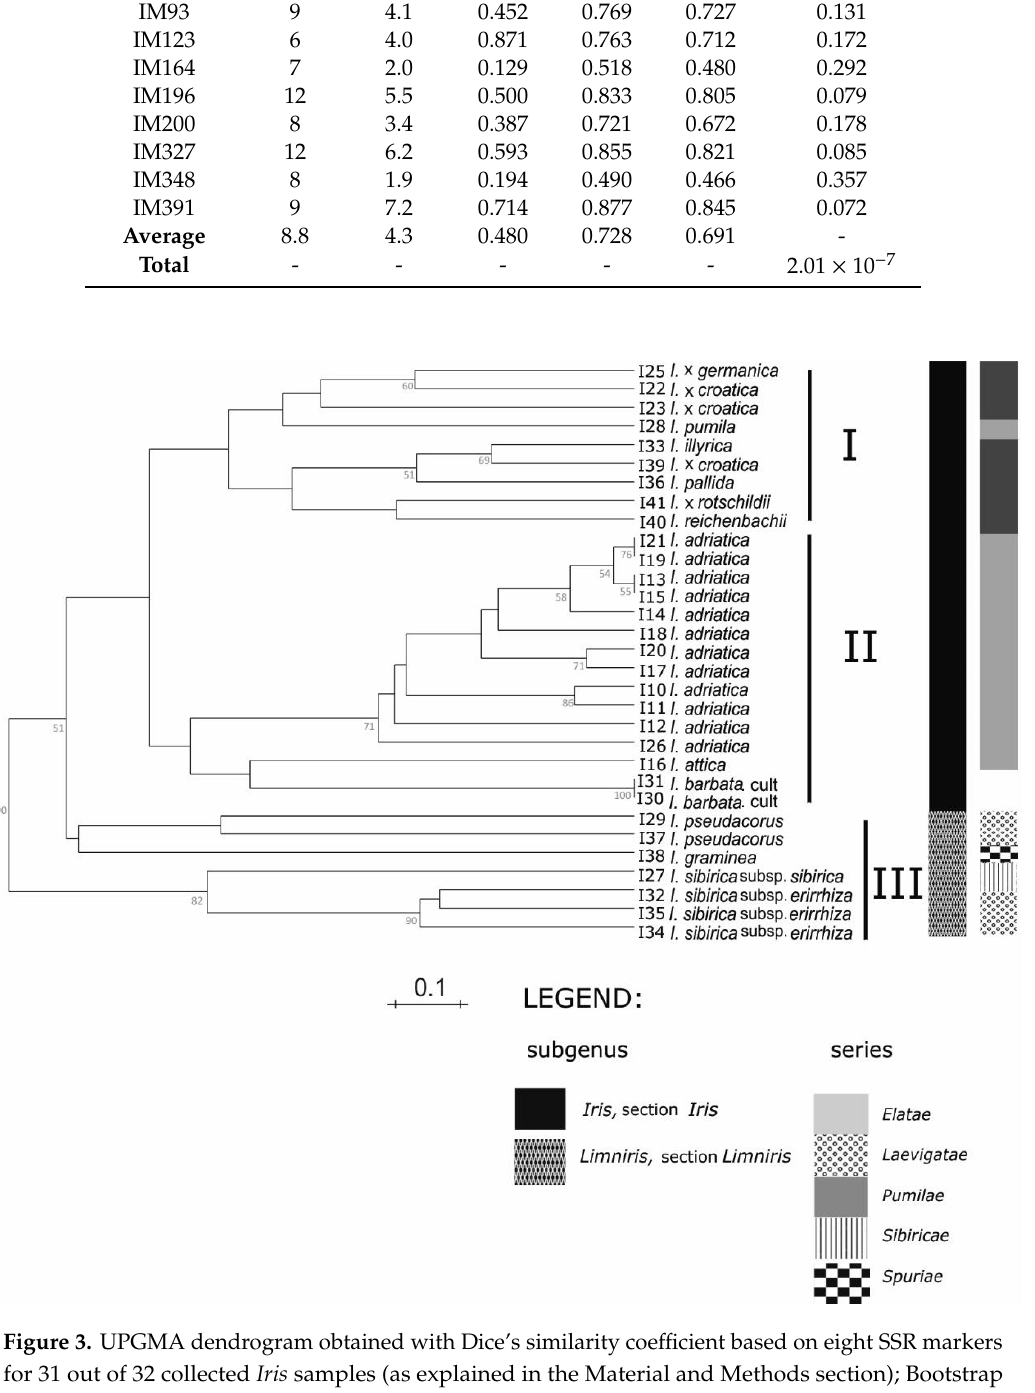
Table 1. Values of observed (H o ) and expected (H e ) heterozygosity, number of alleles (n), e ff ective number of alleles (n e ), polymorphic information content (PIC), and probability of identity (PI) of 8 microsatellite loci for all studied samples of the Alpine-Dinaric taxa of the genus Iris . Locus